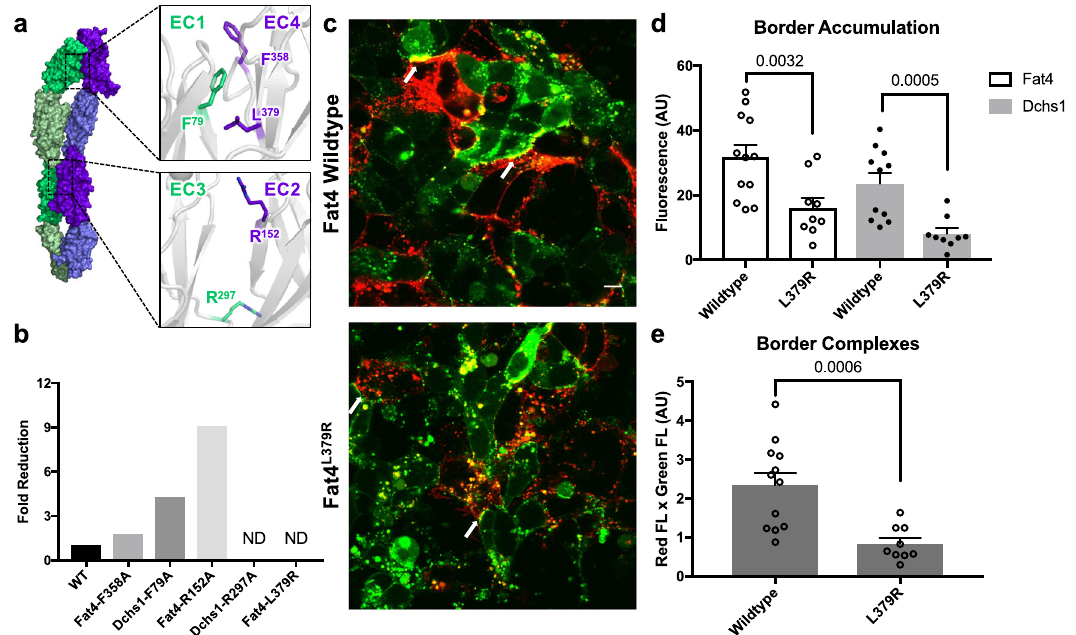
Fig. 3 | Fat4:Dchs1 interface mutations disrupt binding and cellular adhesion. a Structural depiction of mutated Fat4 or Dchs1 interface residues. Individual residuesarelabeledinthezoompanels. b DissociationconstantsbetweenFat4and Dchs1 mutantsweredeterminedbyITCandplotted asfold reductioncomparedto wild-type. Binding was measured between Fat4(EC1 – 4) and Dchs1(EC1 – 4) con- structs.(ND=notdetermined) c Confocalmicrographs(scalebar:10 µ m)depicting co-cultures of Dchs1-expressing cells with either Fat4 or Fat4 L379R cells. Border